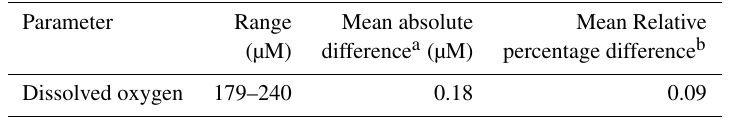
Table 6. Results of duplicates. Parameter Range Mean